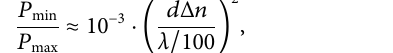
Frontiers in Astronomy and Space Sciences |